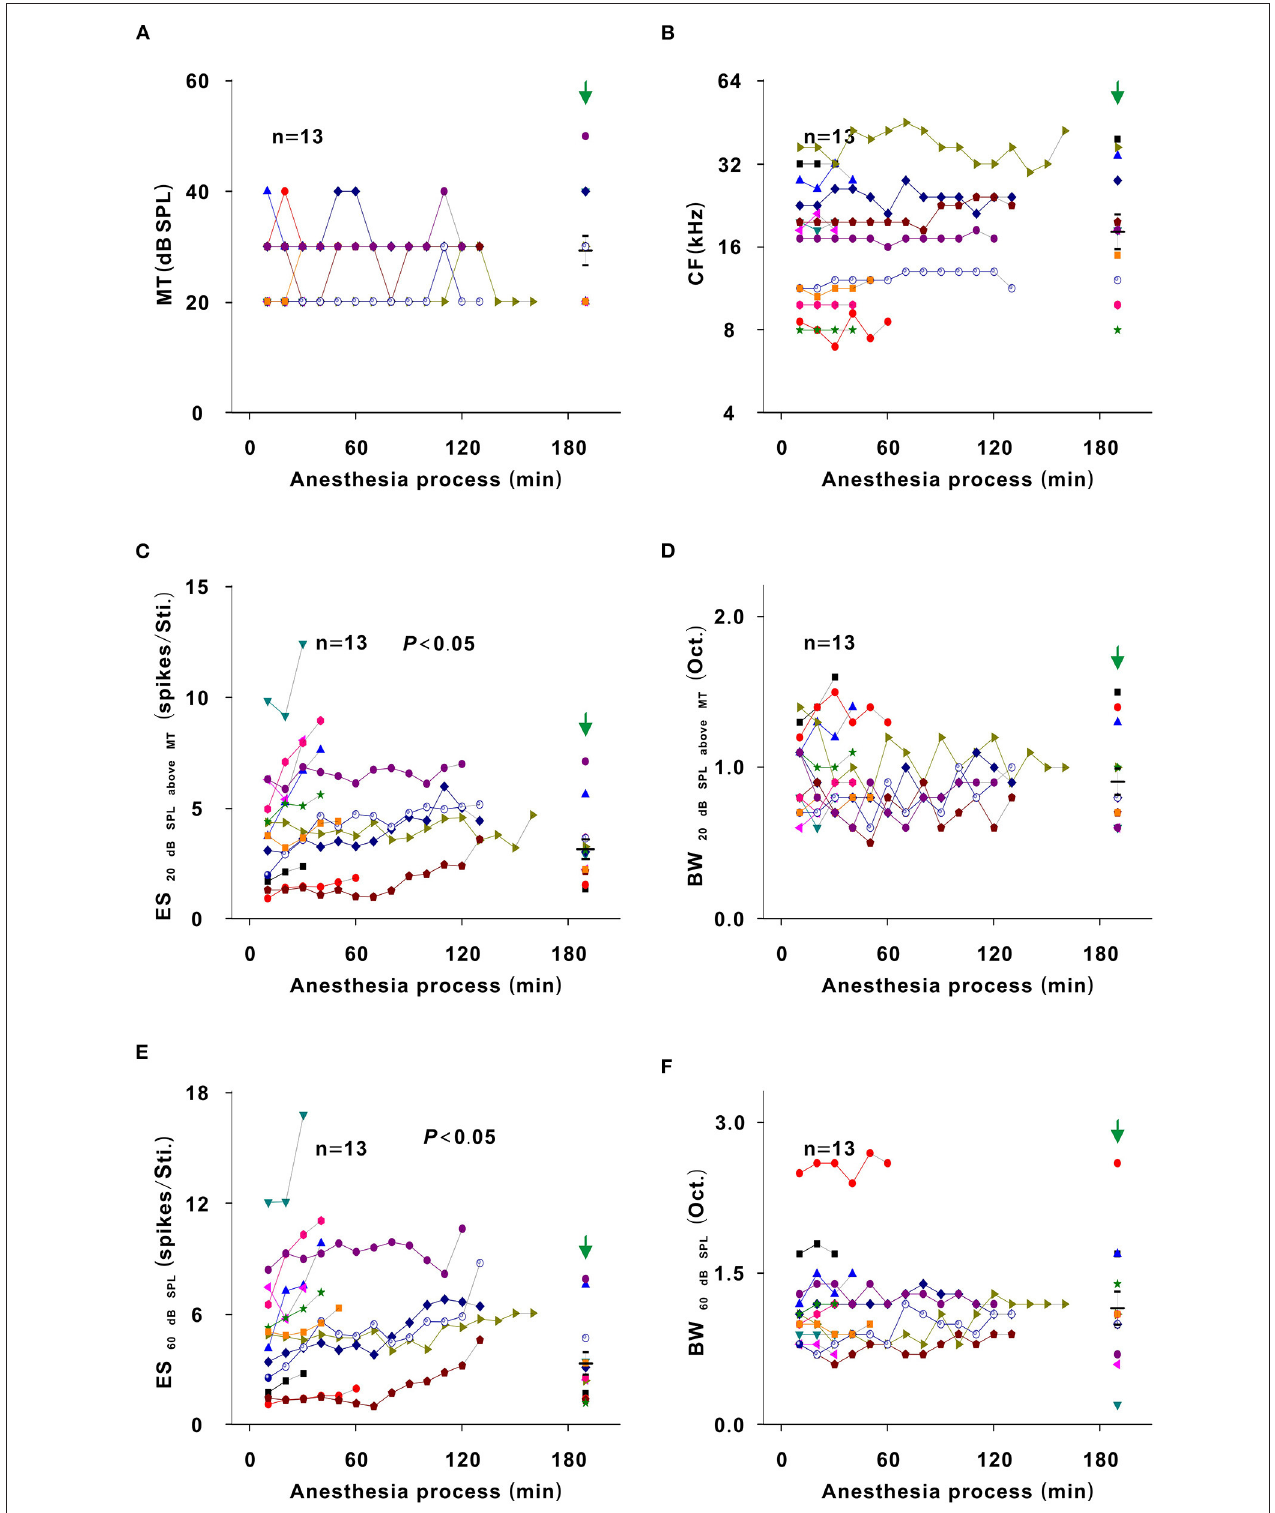
FIGURE 9 | Inhibitory effect of urethane induced changes in the neuron response. Changes in MT (A) , CF (B) , ES 20 dB SPL above MT (C) , BW 20 dB SPL above MT (D) , ES 60 dB SPL (E) , and BW 60 dB SPL (F) in the course of the initial gradual increase in neuron response [first recording session vs. recording session with the strongest response, paired t -test, MT: (24.615 ± 6.602) vs. (24.615 ± 5.189) dB SPL, t = 0.000, P = 1.00; CF: (13.687 ± 4.853) vs. (14.104 ± 4.957) kHz, t = − 1.819, P = 0.094; ES 20 dB SPL above MT : (4.047 ± 2.477) vs. (5.811 ± 2.929) spikes/Sti., t = − 4.728, P = 4.905 × 10 − 4 ; BW 20 dB SPL above MT : (0.977 ± 0.255) vs. (1.023 ± 0.259)